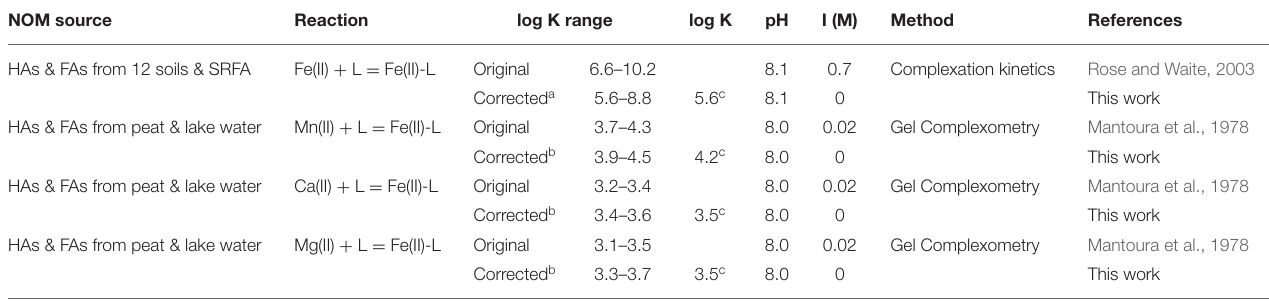
TABLE 6 | Original and corrected binding constants (log K) for 1:1 complexes between metals(II) and the carboxylic acid groups (L) in NOM. NOM